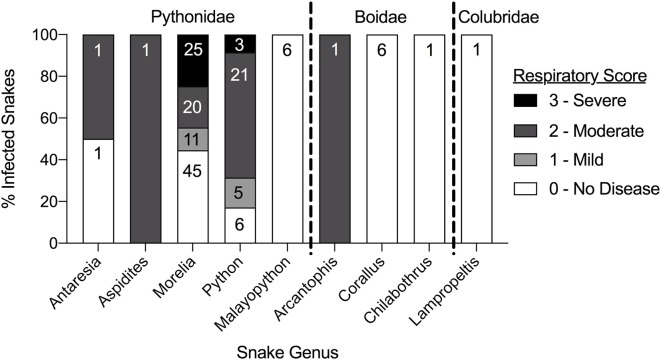
Clinical disease varies by individuals within each snake genus and amongst snake families. Comparison of the respiratory scores of individual serpentovirus-positive snakes within each snake genus. Data is represented as a stacked bar graph totaling 100% of infected snakes in each snake genus. Each respiratory score is represented as a percentage of the total. Values within each fraction of the total indicate the sample size (N).